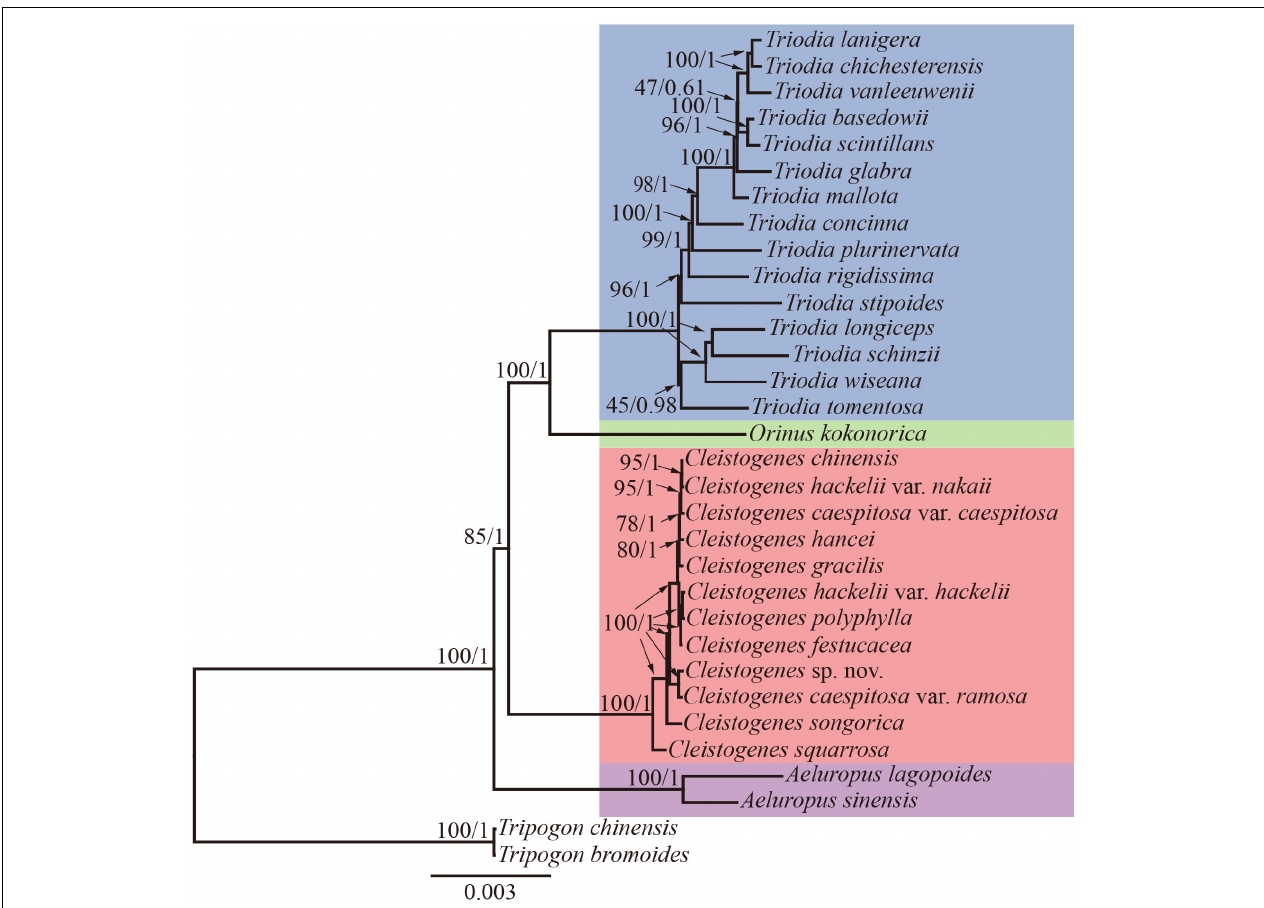
FIGURE 6 | The ML phylogeny of Cleistogenes and its closely related genera based on complete plastomes. The obtained bootstrap values (BS) and Bayesian inference posterior probabilities (PP) are marked above the tree node (BS/PP). Cleistogenes taxa (including 8 species and 4 varieties) are highlighted in red, Orinus species are highlighted in green, Triodia species are highlighted in blue, and Aeluropus species are highlighted in